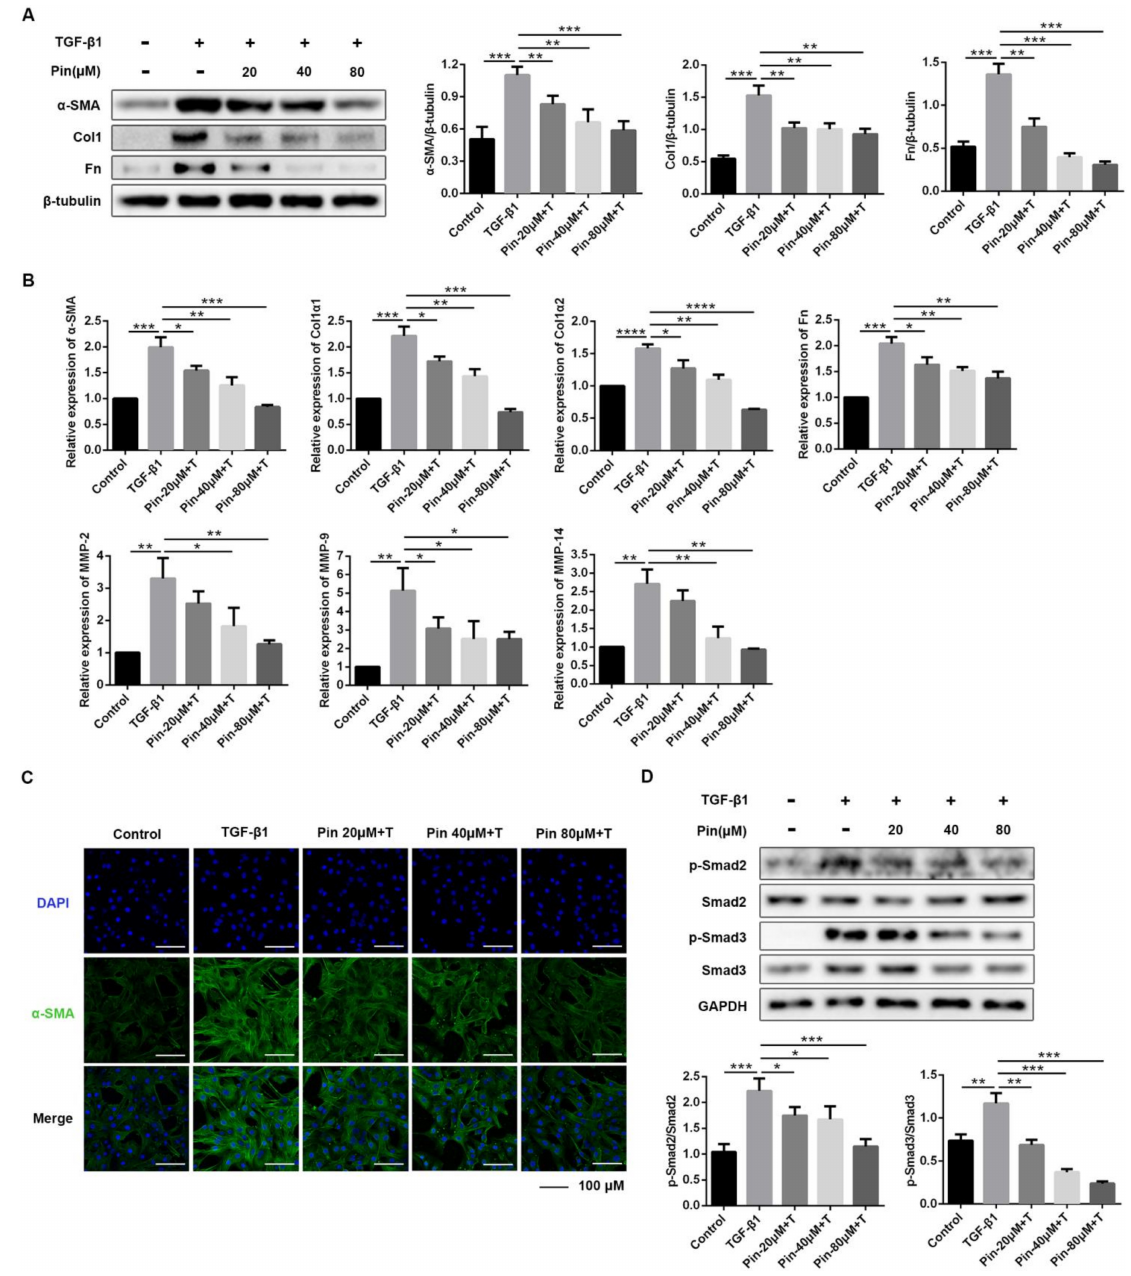
Figure 3. Pinocembrin attenuates TGF- β 1-induced mouse primary dermal fibroblasts activation. ( A ) DFs were treated with TGF- β 1 (5 ng · mL − 1 ) and pinocembrin (0, 20, 40, 80 µ M). ( A ) Western blot analysis of α -SMA, Col1, and Fn at 24 h